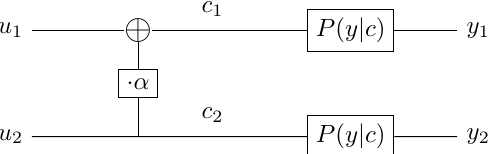
Figure 12: Polar code 2 × 2 kernel defined over a q − ary field. Note that α is an element of the field F q